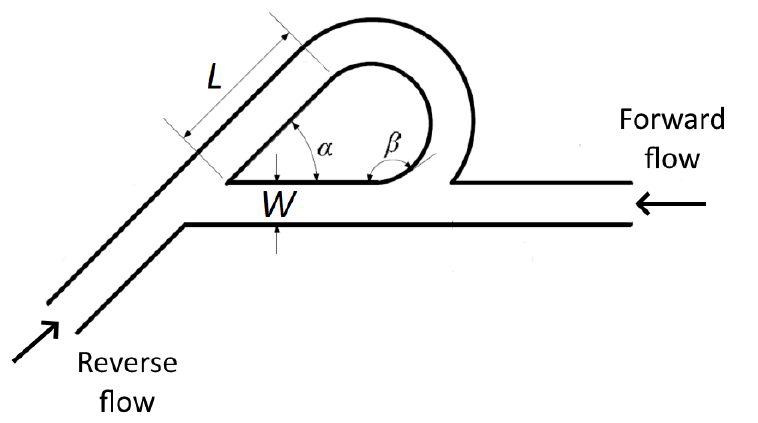
Figure 3. The basic scheme of Tesla valve design indicates different dimensions and parameters—here, W —valve width, L —length of the straight segment of the valve channel, α —valve side-channel leaving angle, and β —valve side-channel return angle.